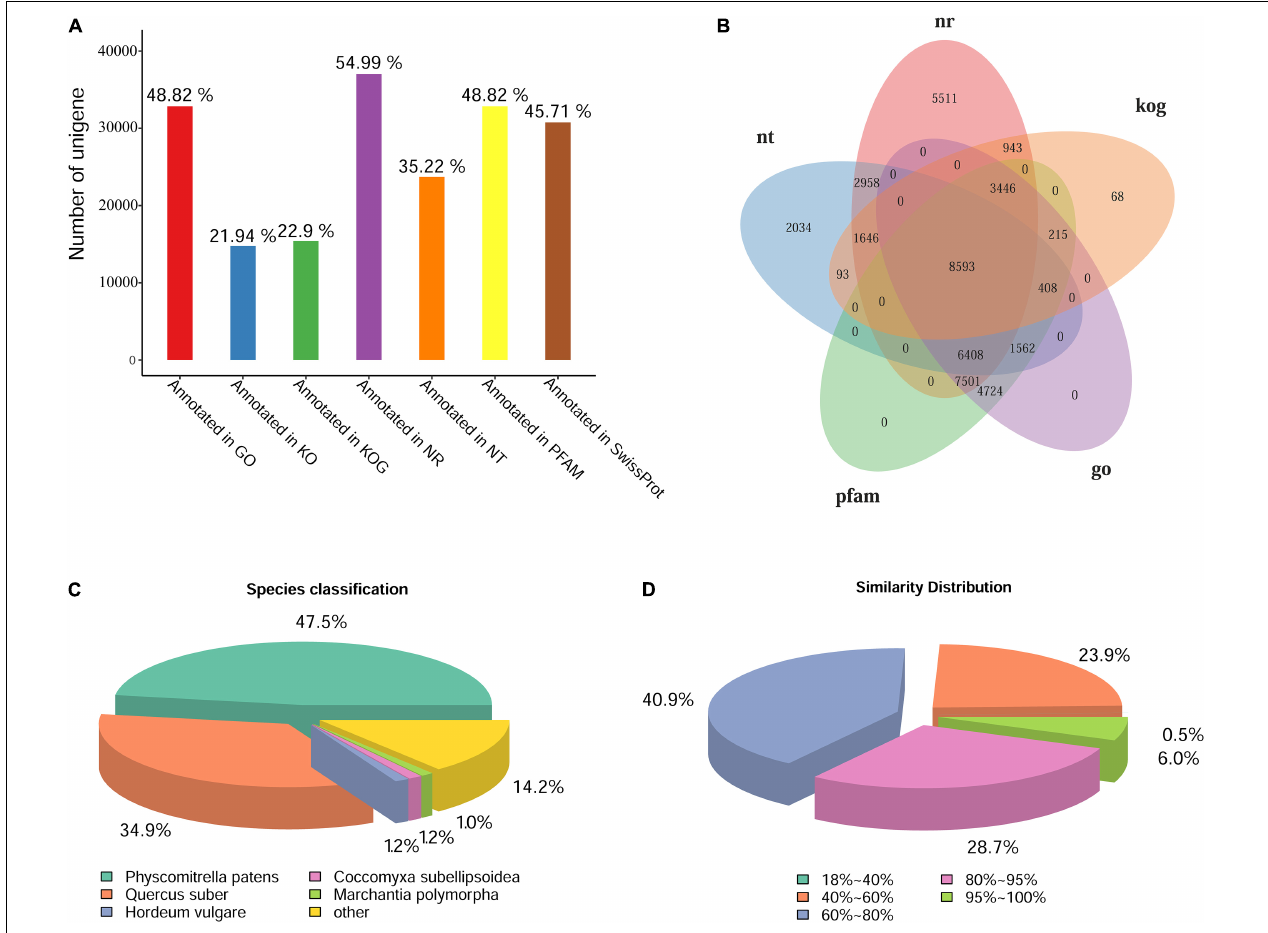
FIGURE 3 | The statistics of functional annotation of the Antarctic moss genes. (A) The statistics of gene annotation rate in seven databases. (B) Venn diagram of five database annotation results. (C) The statistics of species classification. (D) The statistics of similarity distribution. Bar = 0.5